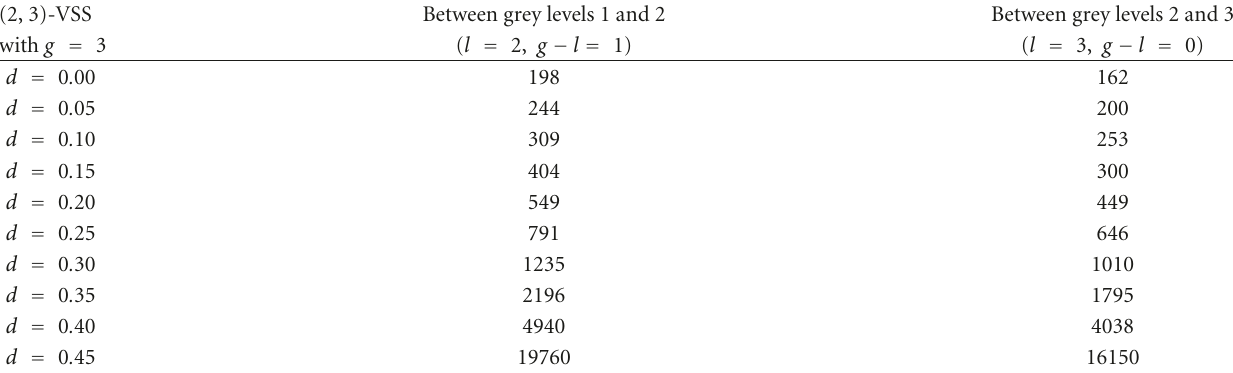
Table 3: Minimum region sizes of the proposed (2,3)-VSS scheme with g = 3. Between grey levels 1 and 2 Between grey levels 2 and